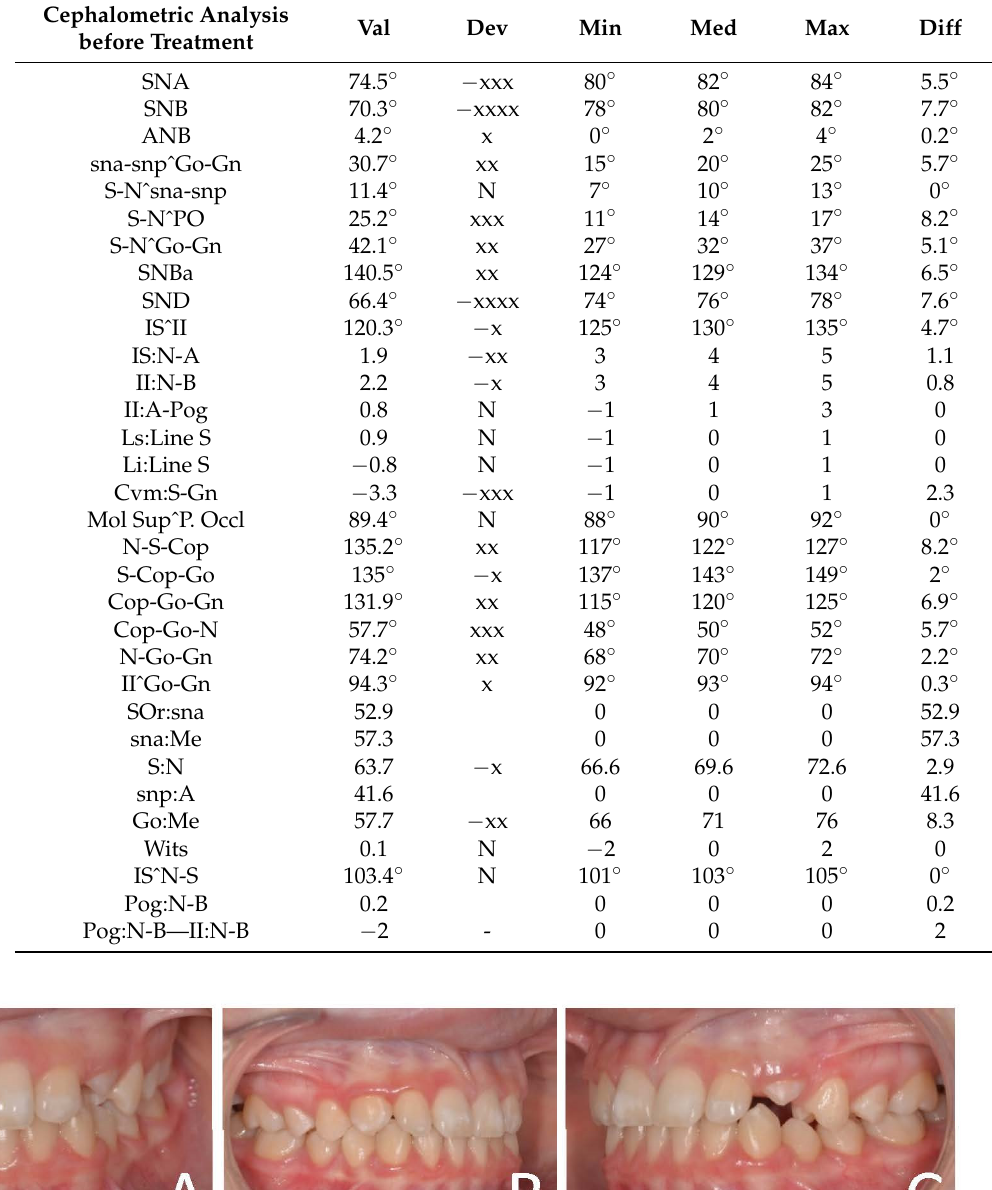
Table 7. Cephalometric analysis before treatment.